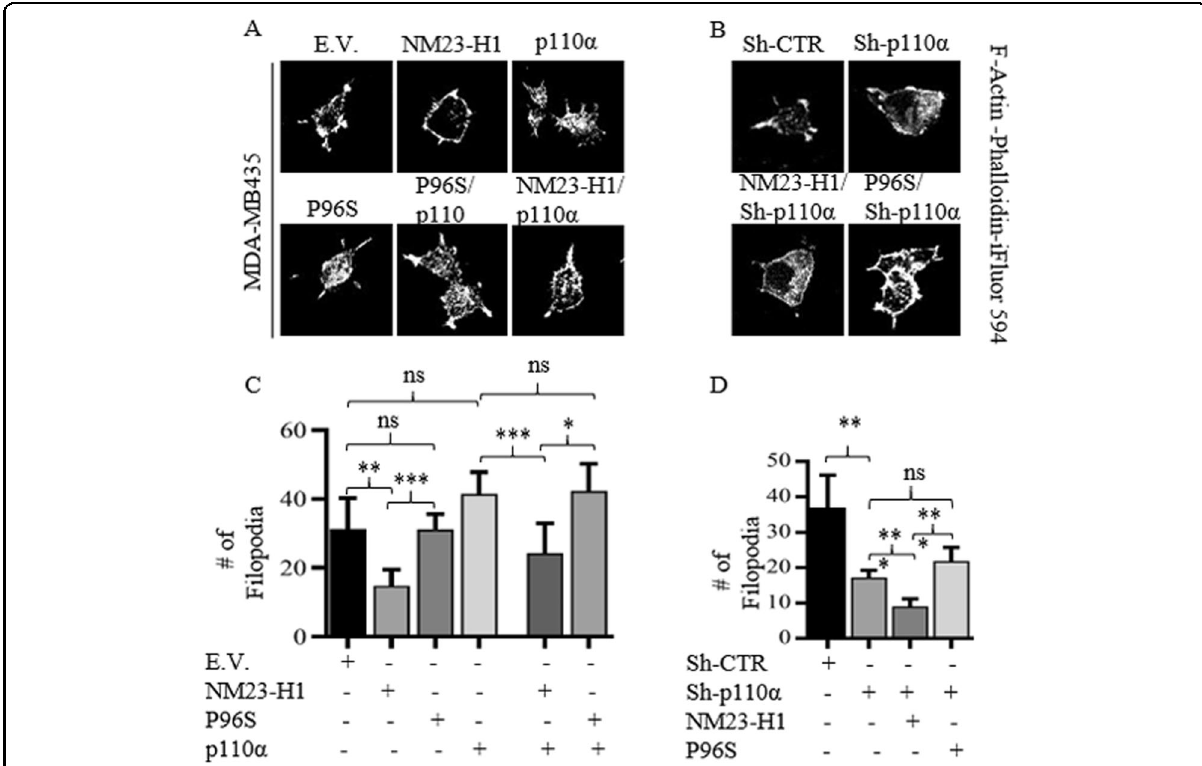
Fig. 6 NM23-H1 suppresses the induction of Filopodia structures. A , B Cell morphology and fi lopodia structures were analyzed using Fluorochrome-tagged-Phalloidin to stain F-actin. Confocal Images shown were taken at ×60 magni fi cation. Cells were fi xed and stained for F-Actin with Fluorochrome-tagged-Phalloidin. C , D Filopodia structures were manually counted and the average of 5 independent fi elds is shown. T -test statistical analysis was performed. n = 3. (* p < 0.05; ** p < 0.01; *** p < 0.001; ns not statistically signi fi